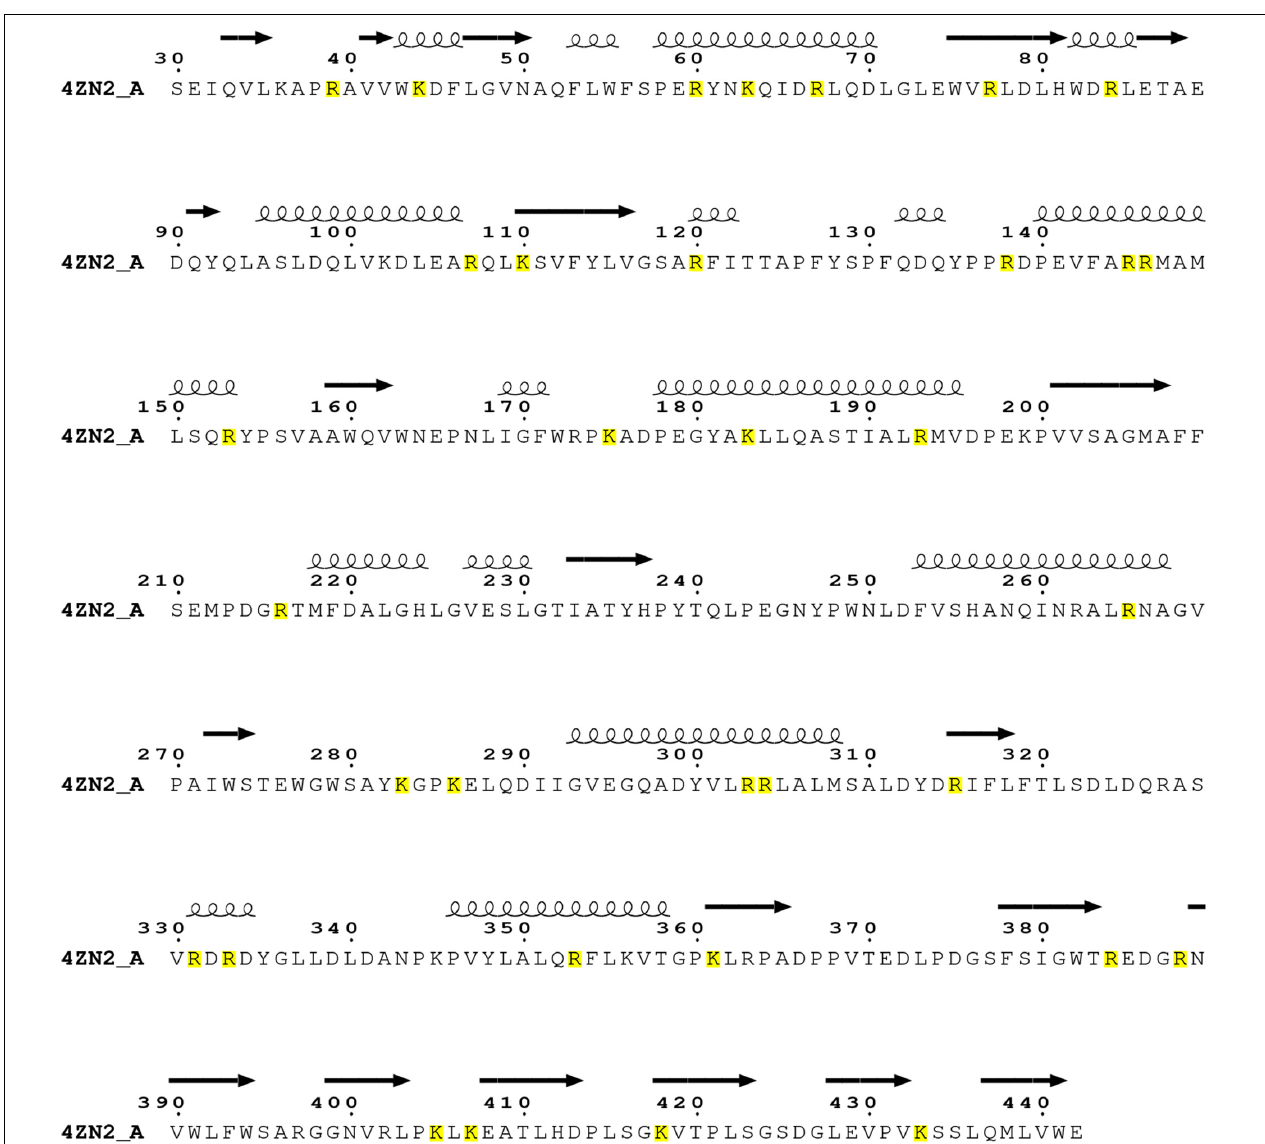
FIGURE 1 | Sequence analysis on the trypsin cleavage residues (highlighted with yellow color) in PslG (PDB: 4ZN2) identified through LC-MS/MS. The catalytic domain of PslG includes residues 47–358, whereas the carbohydrate-binding domain (CBM) of PslG consists of residues 31–42 and